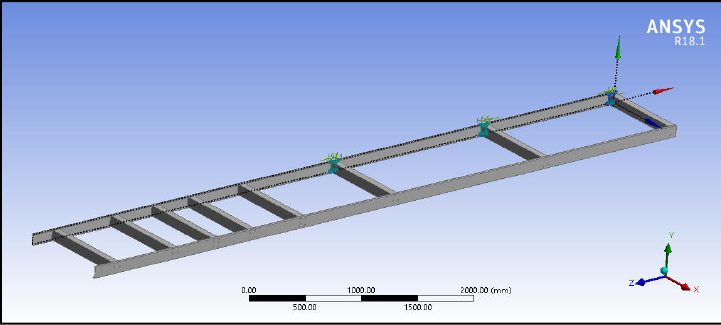
Figure 2. CAD model of chassis (axis origin is the front of vehicle).